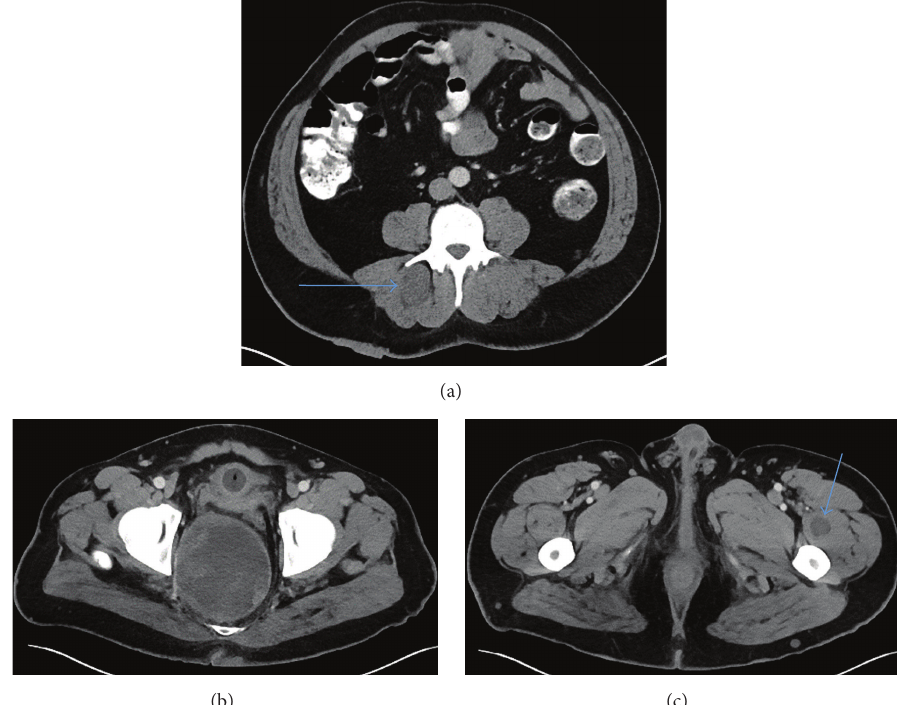
Figure 6: (a) Axial CT right shows right erector spinae/multifidus muscle neurofibroma (arrow); the attenuation of the mass is about the same to slightly less than that of muscle. (b) Axial CT shows heterogeneous pelvic mass. (c) Axial CT shows left vastus medialis/intermedius muscle fibroma (arrow); the attenuation of the mass is less than that of muscle.